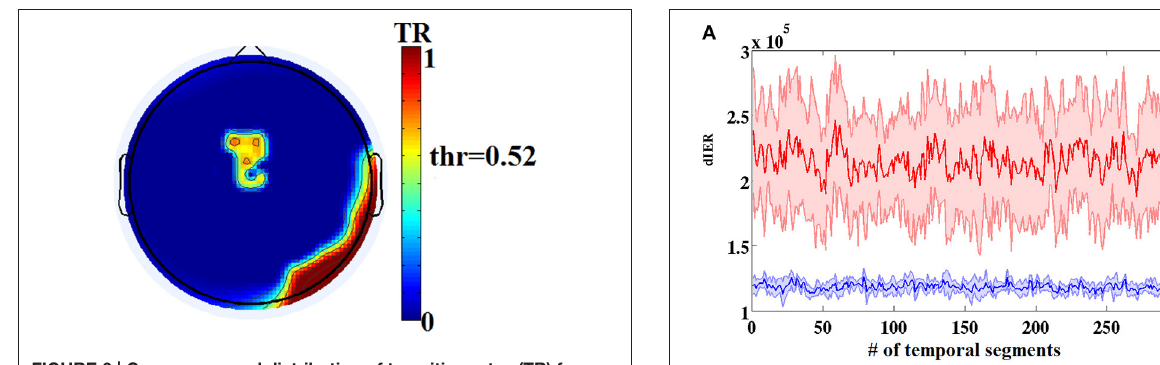
FIGURE 6 | Group-averaged distribution of transition rates (TR) for within-sensor PAC-interactions in the group of RD participants. Thresholding (based on mean +2 SDs of the 248 TR values) has been applied revealing sensors located over right hemisphere temporo-parietal and occipito-temporal regions and the midline, that show maximum instability of local PAC interactions.